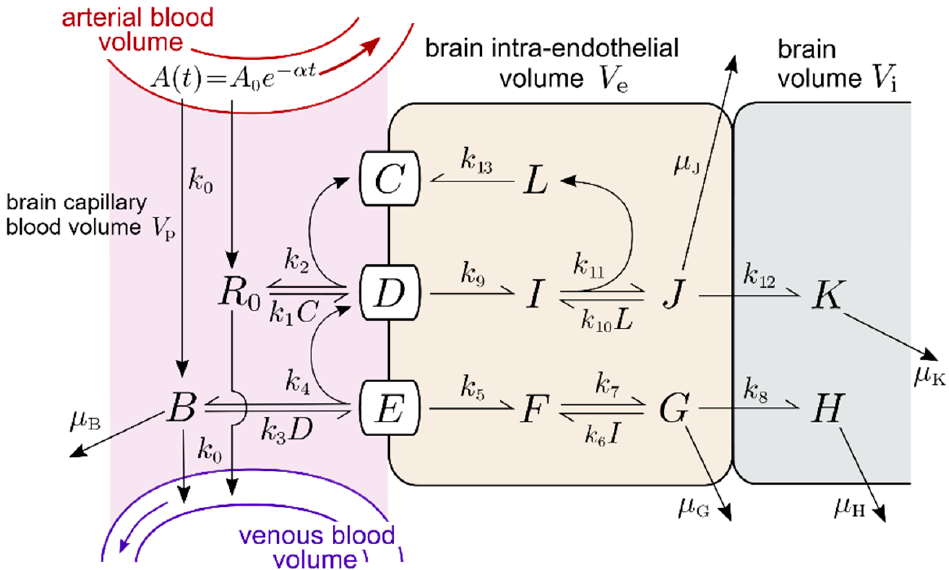
Figure 1. Transferrin receptor (TfR) model. Concentration variables in the relevant tissue compart- ments are defined in Table 1. Basal parameter values are given in Table 2. A ( t ), the MAb concentration in the arterial blood volume after injection reaches maximum value A 0 and is assumed to clear at rate α . The rate k 0 describes the effective transfer rate into and out of the capillary blood volume and depends on the effective flow through the capillary bed. Other association, dissociation, and endocytosis rates are labeled k , while degradation/removal rates are labeled µ . Table 1. Definitions of concentration variables for TfR